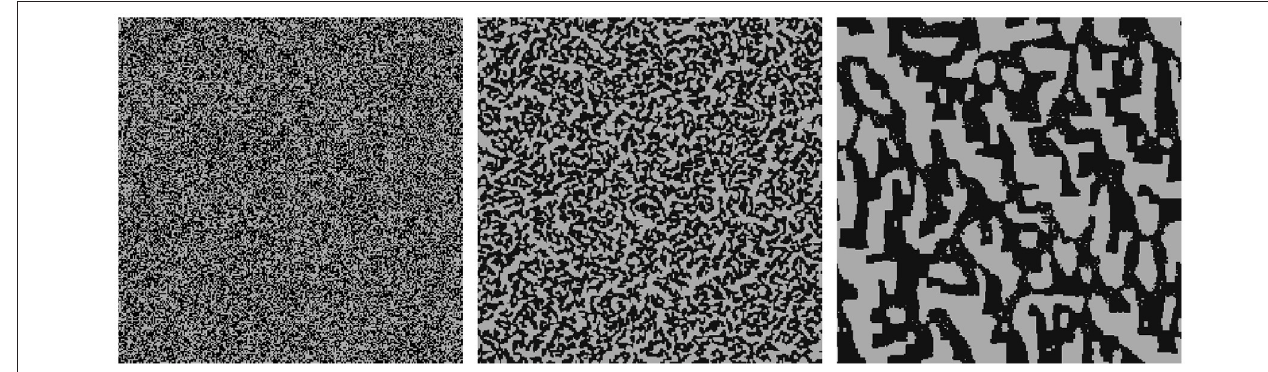
FIGURE 7 | Self organization depending on range of attraction: (Left) Initial, random configuration of single solid cells (black) with porosity θ = 0.5; (Middle) quasi-stationary state with stencil 1, (Right) quasi-stationary state with stencil 3.